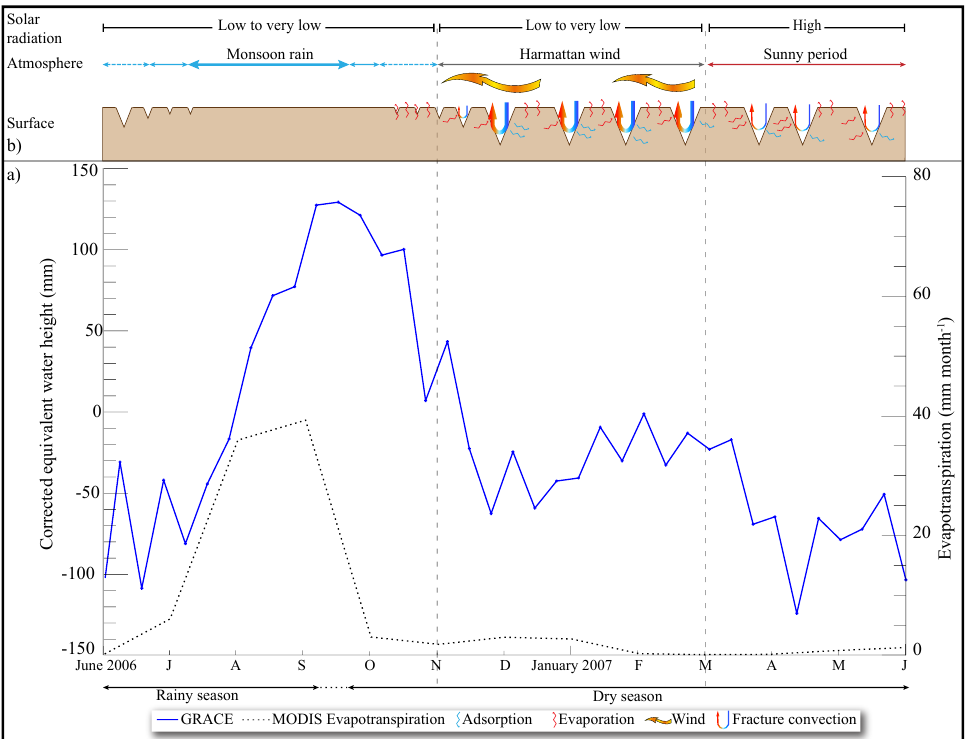
Figure 14. ( a ) Plot of the EWH and the ET rate evolution from the beginning of the 2006-WAM episode until the beginning of the 2007 one. This illustrates the behavior of both signals during the wet and dry seasons. In both signals, the ET rate increase and the DSWI, occurring between December and March, is visible. ( b ) Evolution of the vertical permeability (linked to the opening of desiccation cracks), the atmospheric processes, and the solar radiation through the wet and dry season. The ET rate increase and the DSWI occurs when the Harmattan wind is blowing. The seasonal variation of the desiccation cracks opening permits the development, at night, of a thermally-driven convective circulation inside the cracks. During the Harmattan period, the excess of atmospheric relative humidity in comparison to the one in the soil leads to an increase of the water amount by adsorption in the shallow